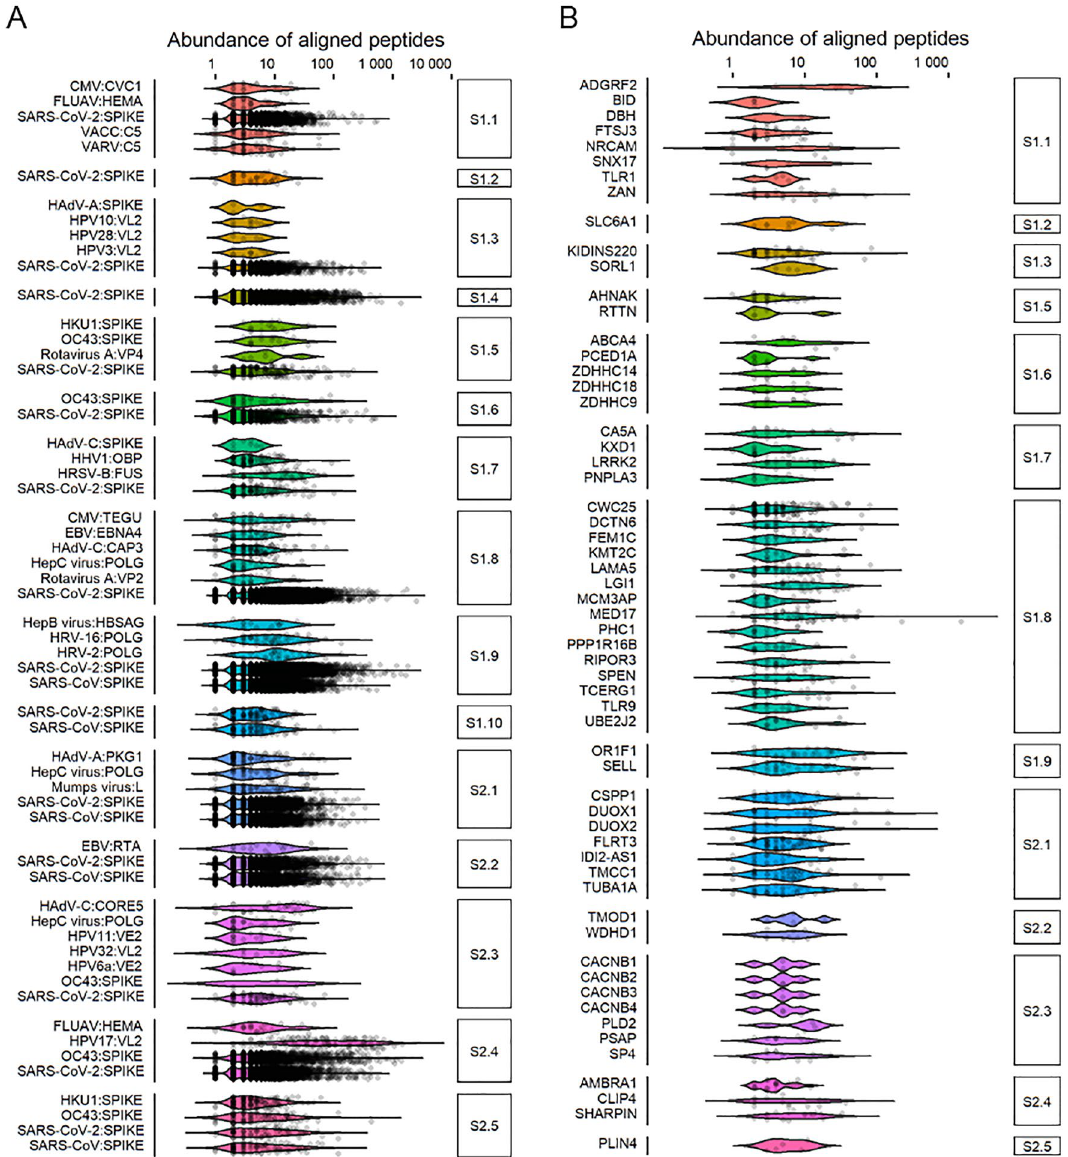
Figure 2. 15 SARS-CoV-2 S protein epitopes mimic common viral protein antigens and self-proteins implicated in normal development and disease. Pathogen proteins and human proteome were accessed from UniProtKB and aligned with 13,500 most abundant IgG-bound 12-mer peptides containing one representative SARS-CoV-2 S protein epitope (from S1.1 to S2.5) using standalone BLAST with alignment criteria customised to short sequences. ( A,B) Viral and human proteins mimicked by SARS-CoV-2 S protein epitopes are depicted on violin plots and were identified using blastp alignment analysis at E-value ≤ 0.05 (except for visualising SARS- CoV, SARS-CoV-2, HKU1, and OC43 alignments where E-value was not restricted). Each dot represents the relative abundance of IgG response to a peptide in one sample from the cohort of SARS-CoV-2 naïve subjects (n = 538). See Tables S3 and S4 for detailed information on pathogen and human protein alignments, full protein names and accession